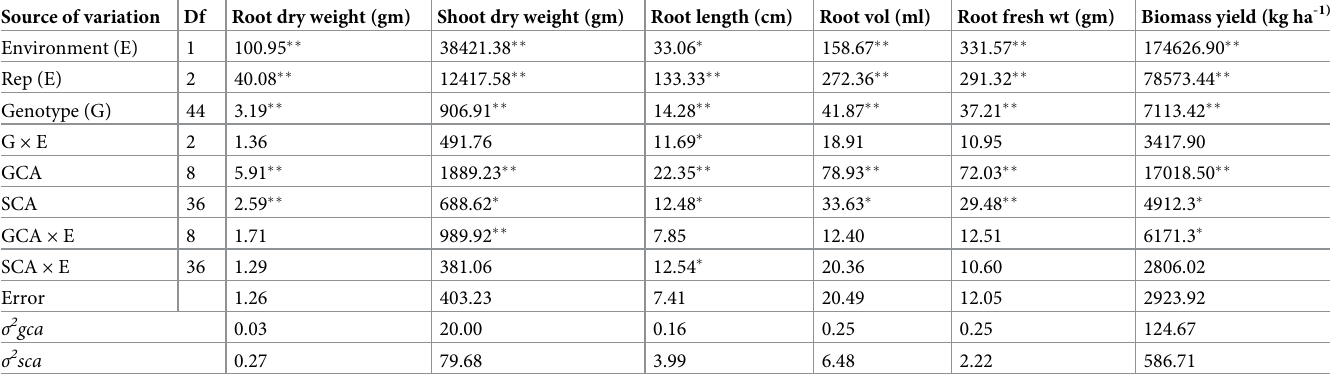
Table 2. Mean squares for root traits of 45 soybean genotypes (parents and progeny populations) evaluated under low P conditions. Source of variation